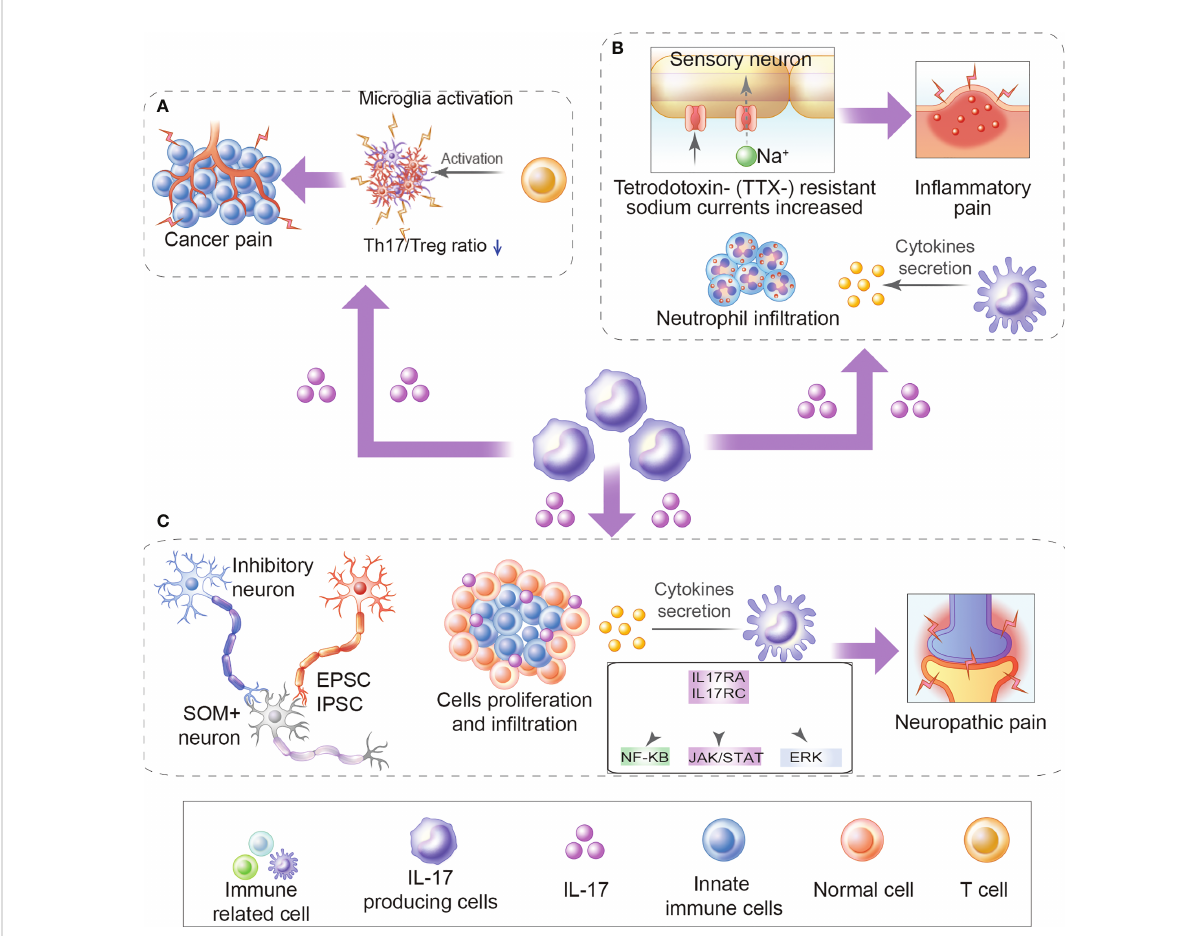
FIGURE 1 Role of IL-17 in chronic pain. (A) The role of IL-17 in cancer pain: For example, increased production of IL-17/IL-17Rs may further promote Th17/Treg in fi ltration and microglia activation during bone cancer pain development. (B) In fl ammatory pain: For example, IL-17 mediates in fl ammatory pain by promoting the production of cytokine and in fl ammatory factors and accumulation of neutrophils and lymphocytes in in fl ammatory sites. Besides, IL-17 upregulates TTX- resistant sodium currents in isolated DRG neurons. (C) Neuropathic pain: For example, IL-17/ IL17Rs regulate EPSCs and IPSCs, promote cytokine production, immune cell activation, and immune cell proliferation and in fi ltration, activates ERK and NF- k B, and JAK/STAT signal